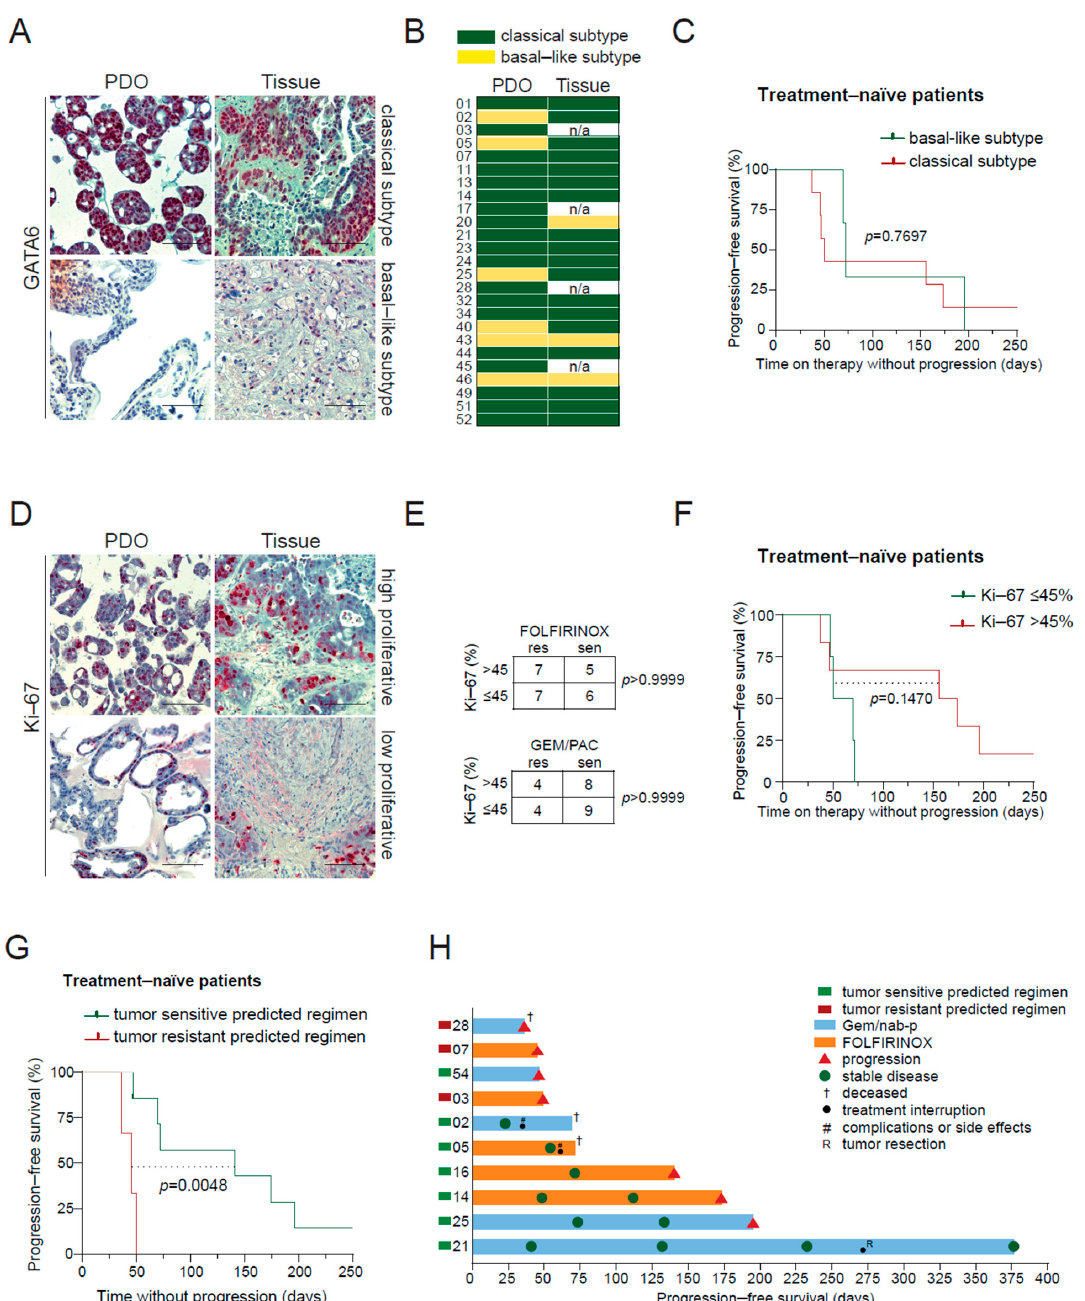
Figure 4. Patient-derived organoid-based drug efficacy prediction and potential clinical impact. ( A ), Immunohistochemistry staining for GATA6 in patient-derived organoids (PDOs) 34 and 43 and corresponding tumor tissue from liver metastases. ( B ), Distribution of classical (green) and basal-like (yellow) subtypes across PDOs and corresponding tumor tissues. ( C ), Kaplan-Meier analysis of progression-free survival (PFS) of treatment-naïve advanced pancreatic cancer (PC) patients according to their classical or basal-like subtype status. ( D ), Immunohistochemistry staining for Ki-67 in PDOs 34 and 49 and corresponding tumor tissue. A tumor cell Ki-67 positivity ≤ 45% shows low proliferation, while Ki-67 >45% denotes high proliferation. ( E ), Contingency table showing proliferation index and sensitivity to chemotherapy regimen in vitro. ( F ), Kaplan-Meier analysis of PFS of treatment-naïve advanced PC patients according to the tumor mitotic index. ( G ) Kaplan-Meier analysis of PFS of treatment-naïve advanced PC patients who received a tumor sensitive or tumor resistant predicted regimen following our PDO-based model. ( H ) Swimmer plot of PFS from treatment-naïve patients. Scale bars represent 100 µ m. PDO, patient-derived organoids; FOLFIRINOX, 5-fluorouracil, leucovorin, irinotecan, and oxaliplatin; Gem/nab-p, gemcitabine, and nanoparticle albumin-bound paclitaxel; res, resistant; sen,